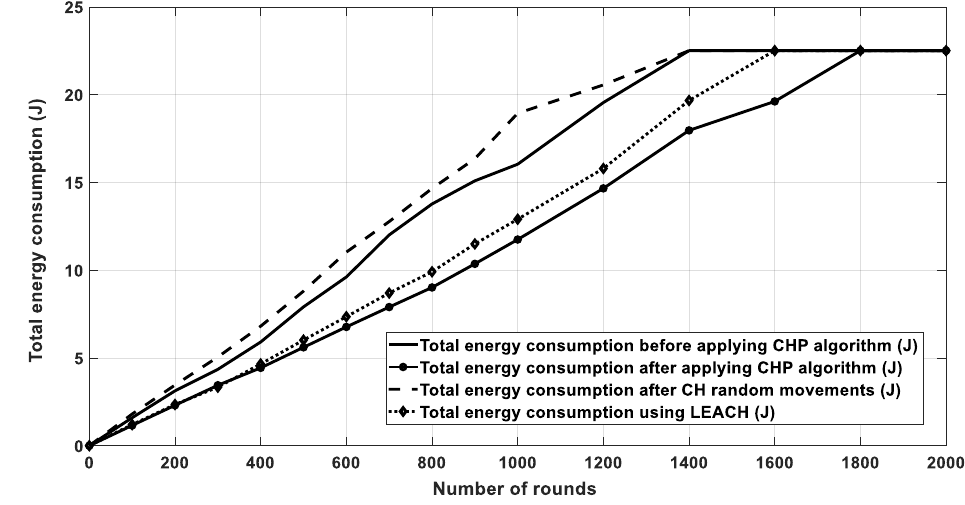
Figure 11. Energy consumption for all the SNs after each round.